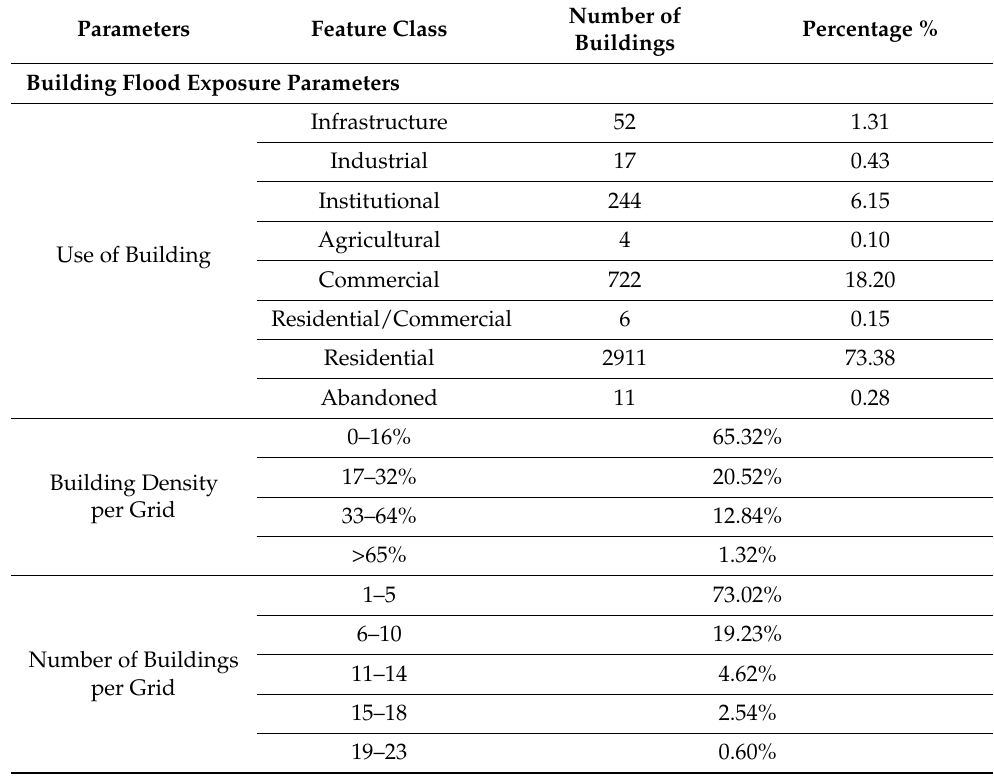
Table A3. Feature count of building flood exposure parameters.